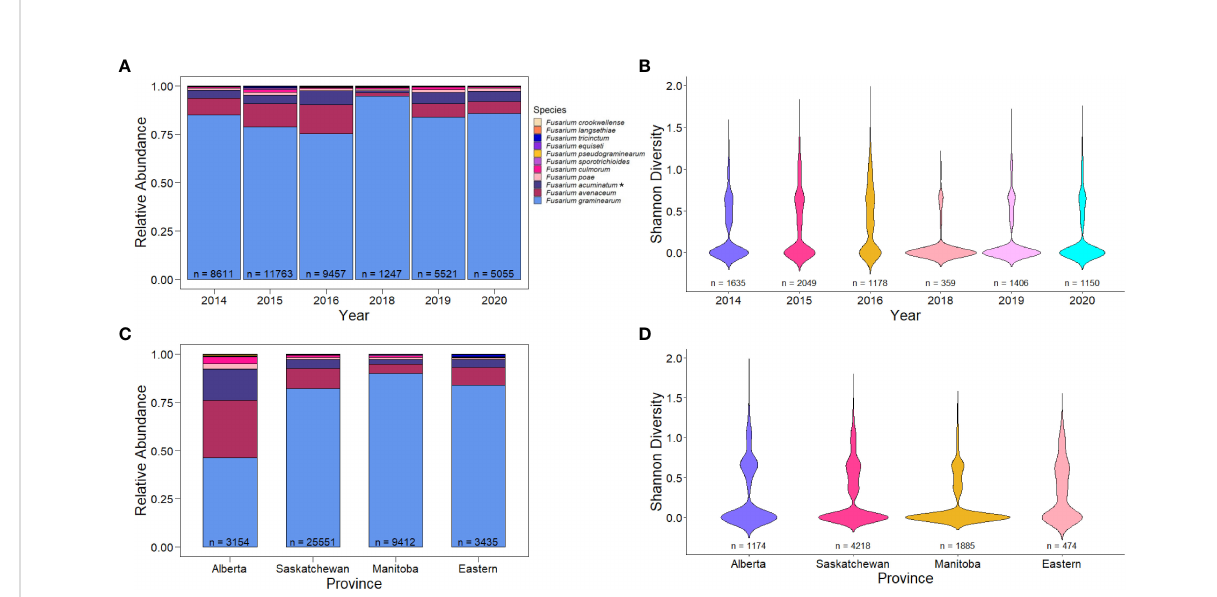
FIGURE 2 Relative abundance and species diversity of Fusarium species in Canada from 2014-2016, 2018-2020. (A) Relative abundance of different Fusarium species in Fusarium damaged kernels (n) by year. (B) Species diversity of different Fusarium species in wheat samples with FDK (n) by year. (C) Relative abundance of different Fusarium species in Fusarium damaged kernels (n) by Canadian provinces. (D) Relative abundance of different Fusarium species in Fusarium damaged kernels (n) across Canadian provinces. Relative abundance is the proportion of species-speci fi c positive qPCR test results out of the total positive test results. Asterisks (*) signify putative F. acuminatum . Species diversity is Shannon ’ s diversity index based on the proportions of species for each